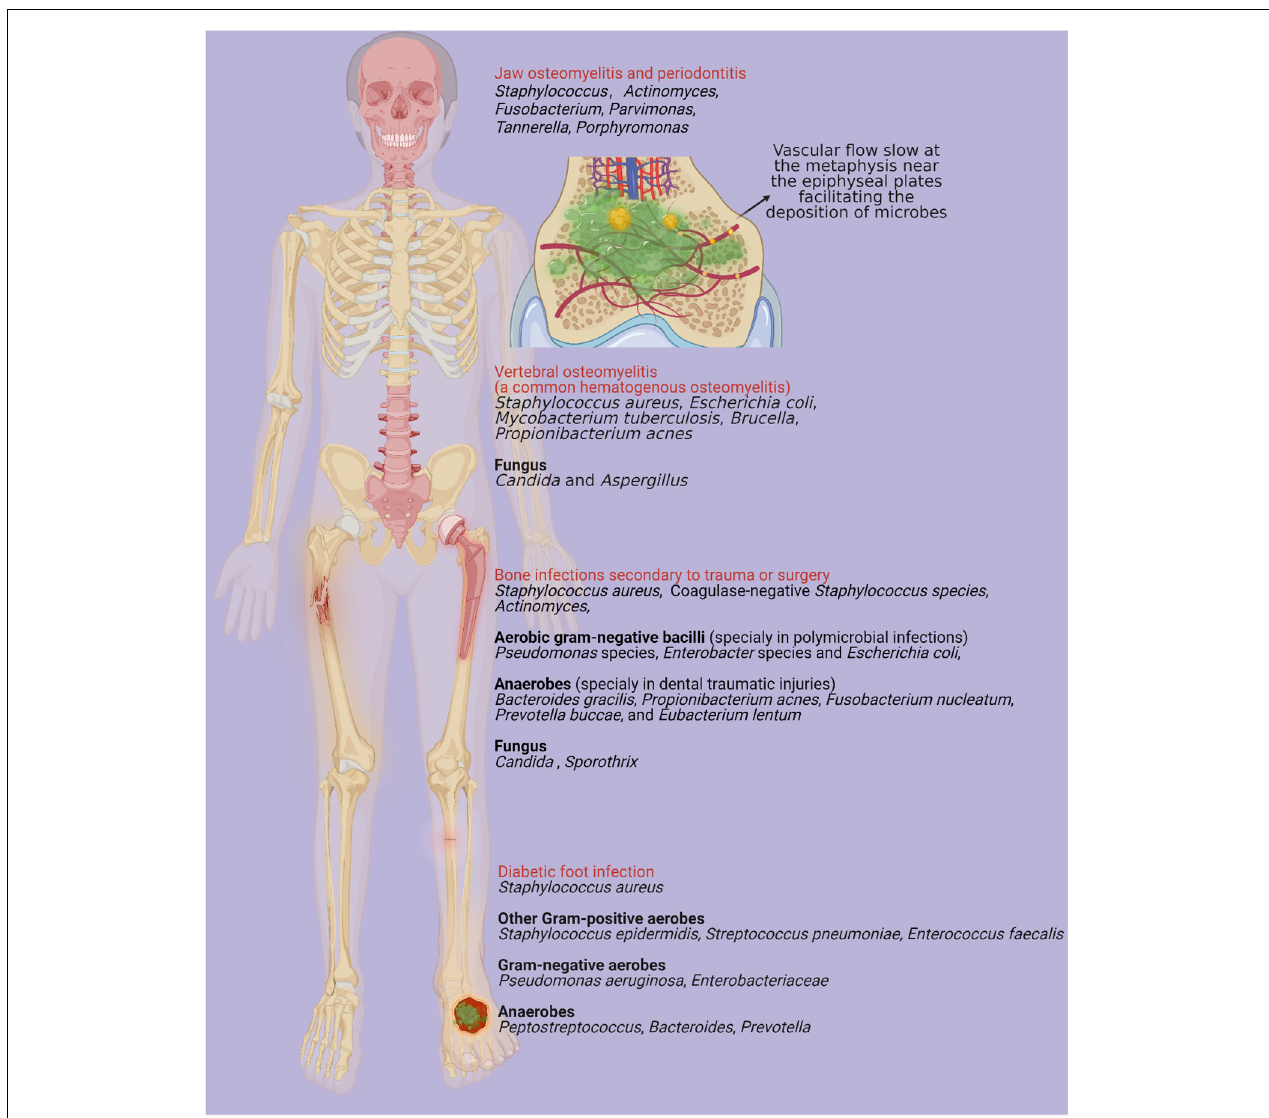
FIGURE 1 | There are various microorganisms associated with different types of bone infections, mainly including jaw osteomyelitis, periodontitis, bone infections secondary to trauma or surgery, diabetic foot infection and hematogenous osteomyelitis (Lew and Waldvogel, 2004). Vascular flow slows at the metaphysis near the epiphyseal plates facilitating the deposition of microbes and vertebral osteomyelitis is one of most common types in hematogenous osteomyelitis (Maamari et al., 2022). Created with